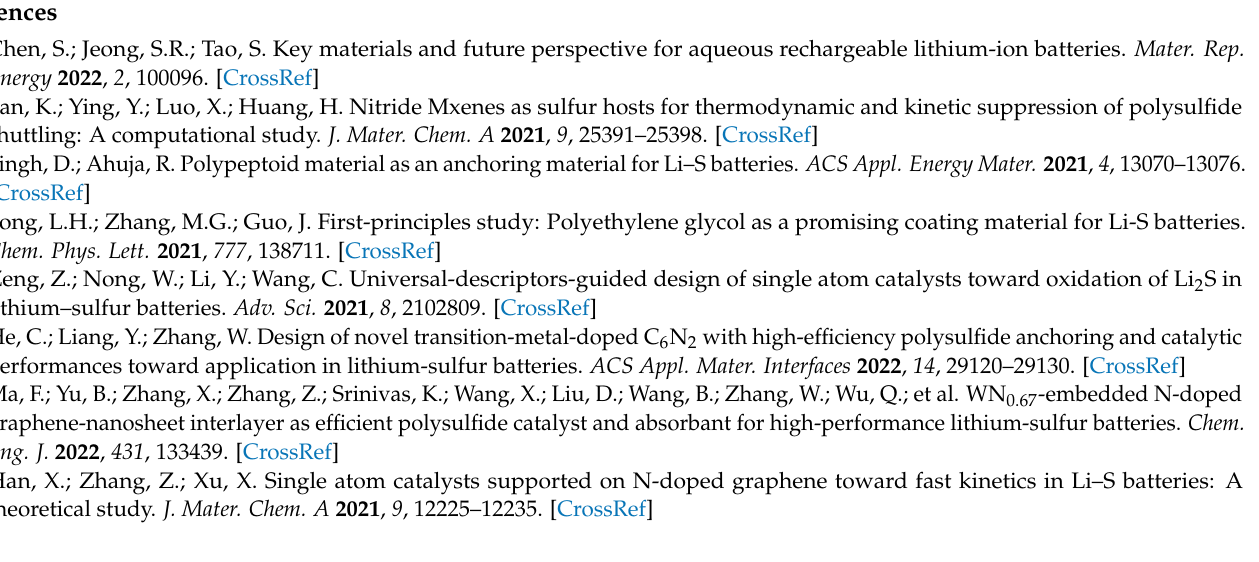
Table S3: The relative energies of Li + diffusion pathways on TM-rTCNQ (TM = V, Cr, Mn, Fe and Co)